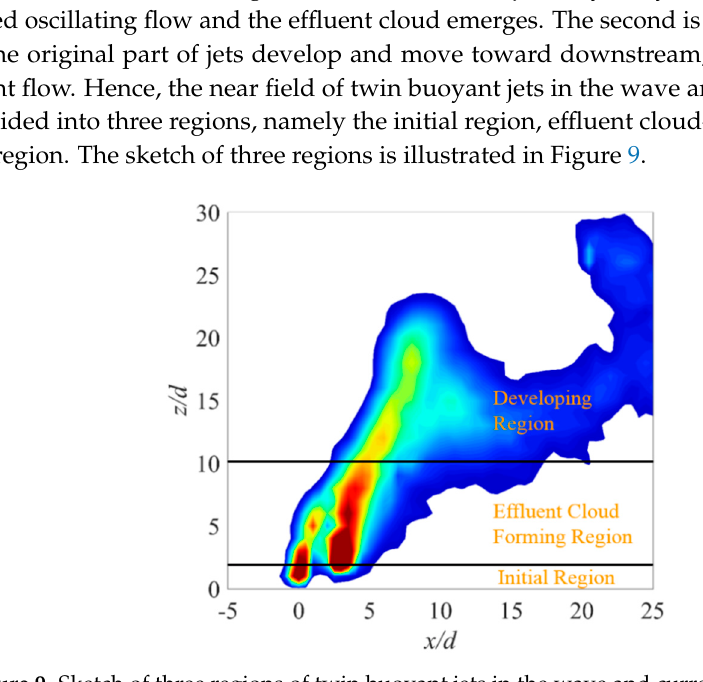
Figure 9. Sketch of three regions of twin buoyant jets in the wave and current environment.